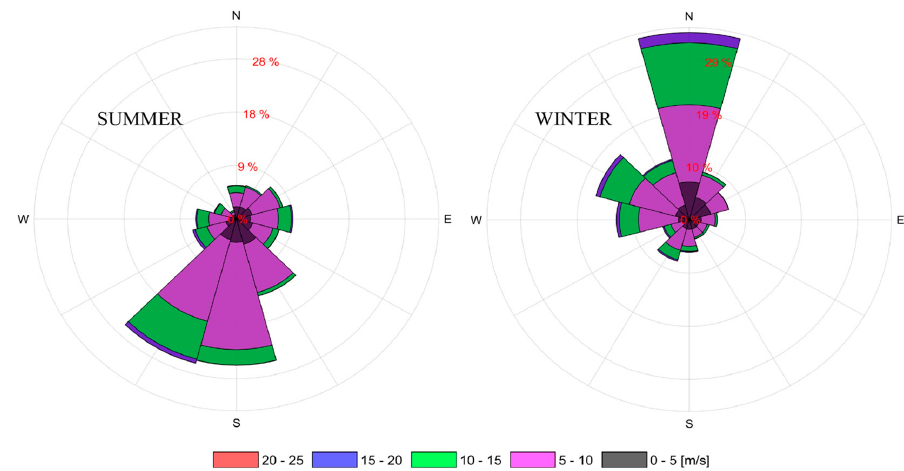
Figure 3. Measured wind data from 1998 to 2013 (mean speed, and direction) at the South Channel Island station during summer and winter months.